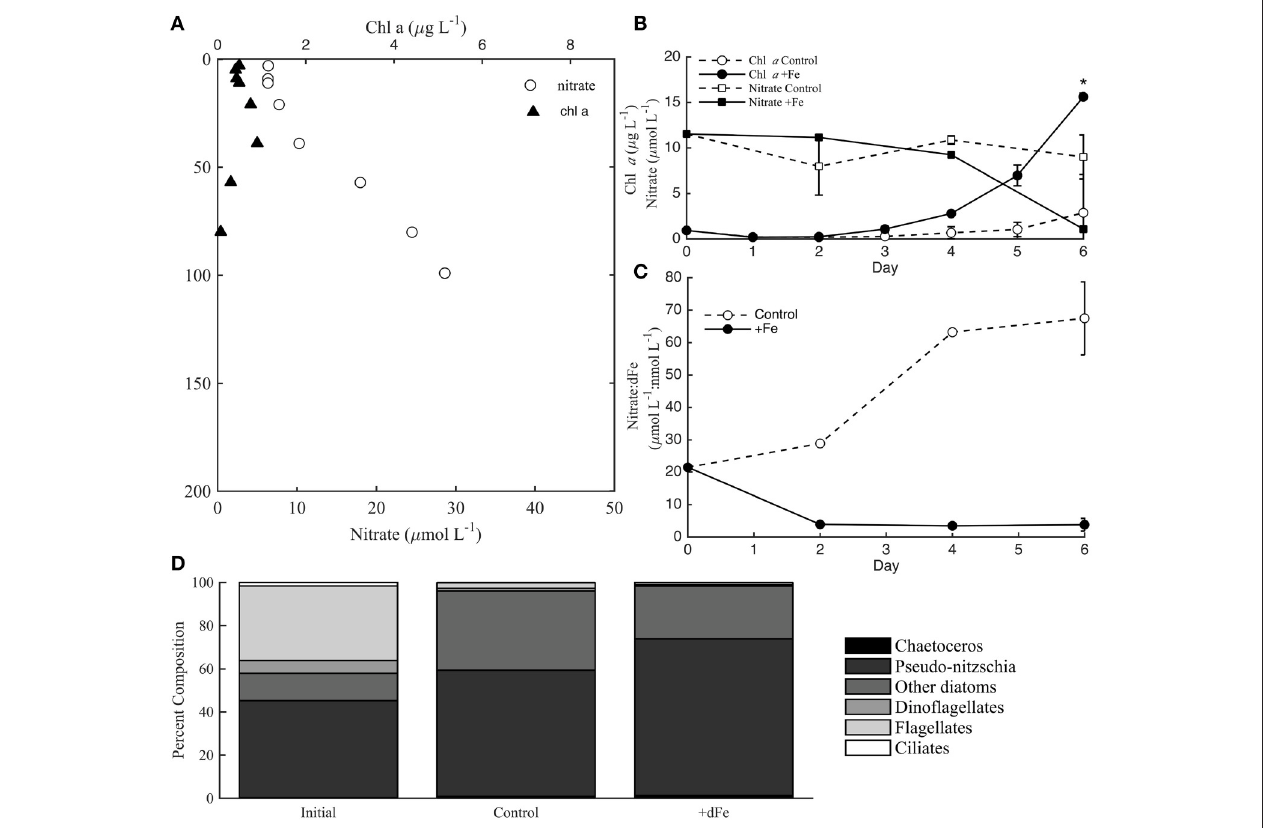
FIGURE 3 | Incubation data from incubation experiment 1 at station 3. Chlorophyll a (chl a ) and nitrate (nitrate + nitrite) distributions in the water column at station 3 (A) . Chl a and nitrate concentrations during the incubation experiment, where * indicates a significance difference in chl a biomass on day 6 ( B ; t- test, p < 0.05 ). Nitrate:dFe ratios throughout the incubation experiment (C) , and phytoplankton cell counts for controls and + Fe treatments (D) . Error bars in panels (A, B, D) represent the standard deviation from the averages of controls (A, B, C) and + Fe treatments (FeA, FeB, FeC) at each time-point.